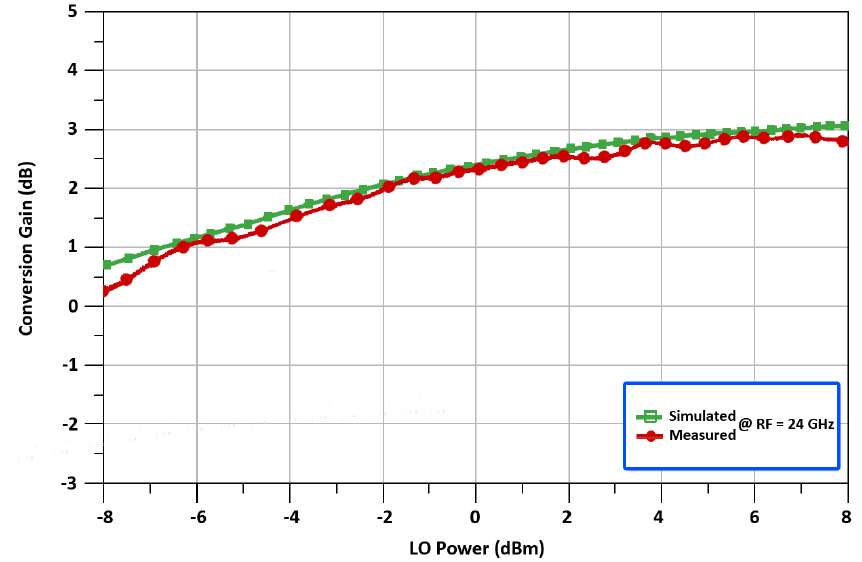
Figure 14. Conversion gain with respect to LO